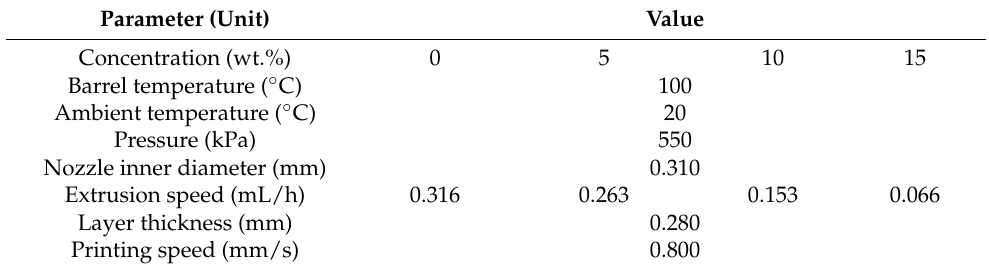
Table 1. Printing conditions for lattice-pattern membranes with different pigment concentrations.